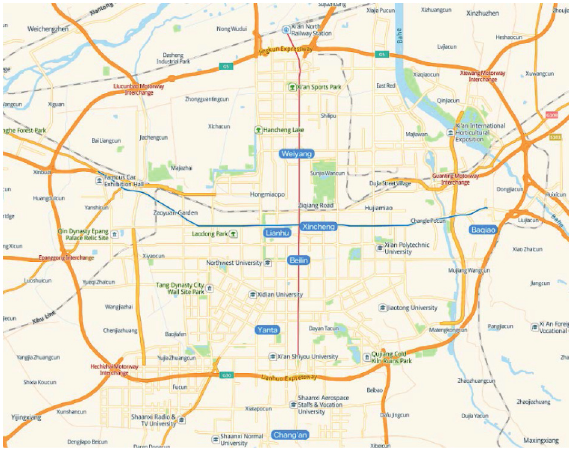
Figure 1: Traffic network in Xi’an